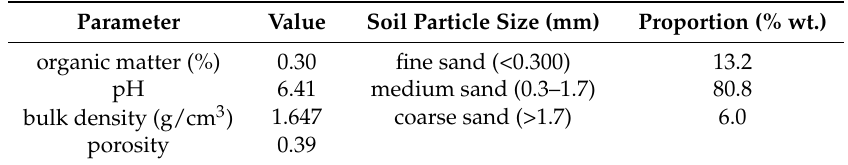
Table 3. Characteristics of the sandy soil used in this